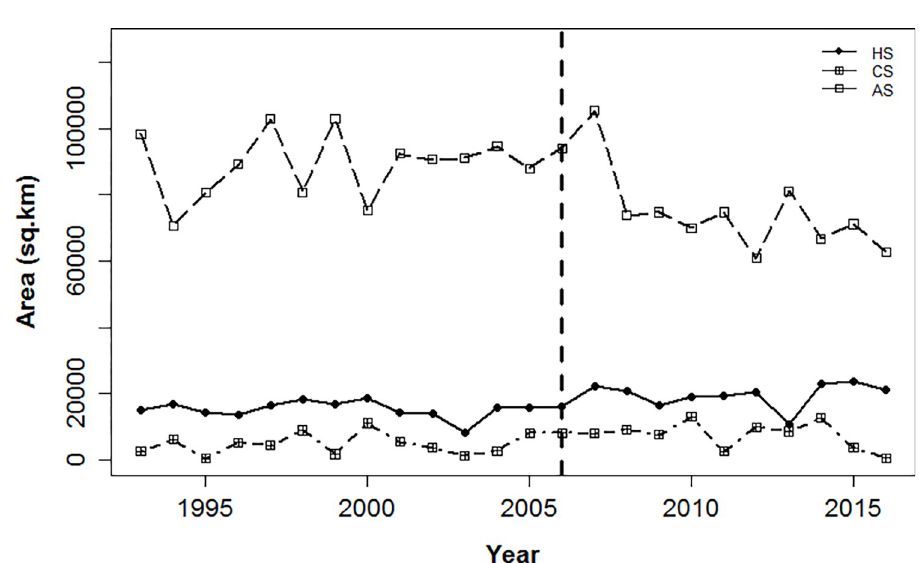
Fig 5. Trend in area (km 2 ) under different levels of pheasant productivity over 24-year and 11-year (vertical line) period across HotSpot (HS), ColdSpot (CS) and AverageSpot (AS).